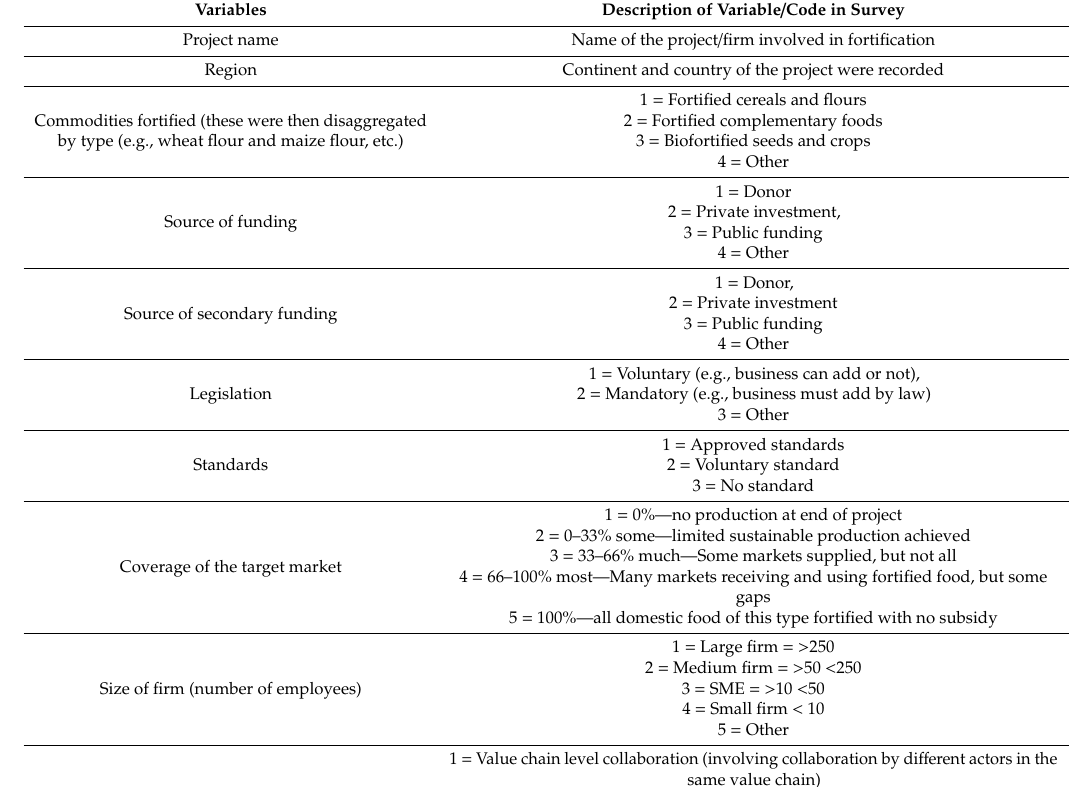
Table 2. Survey variables and